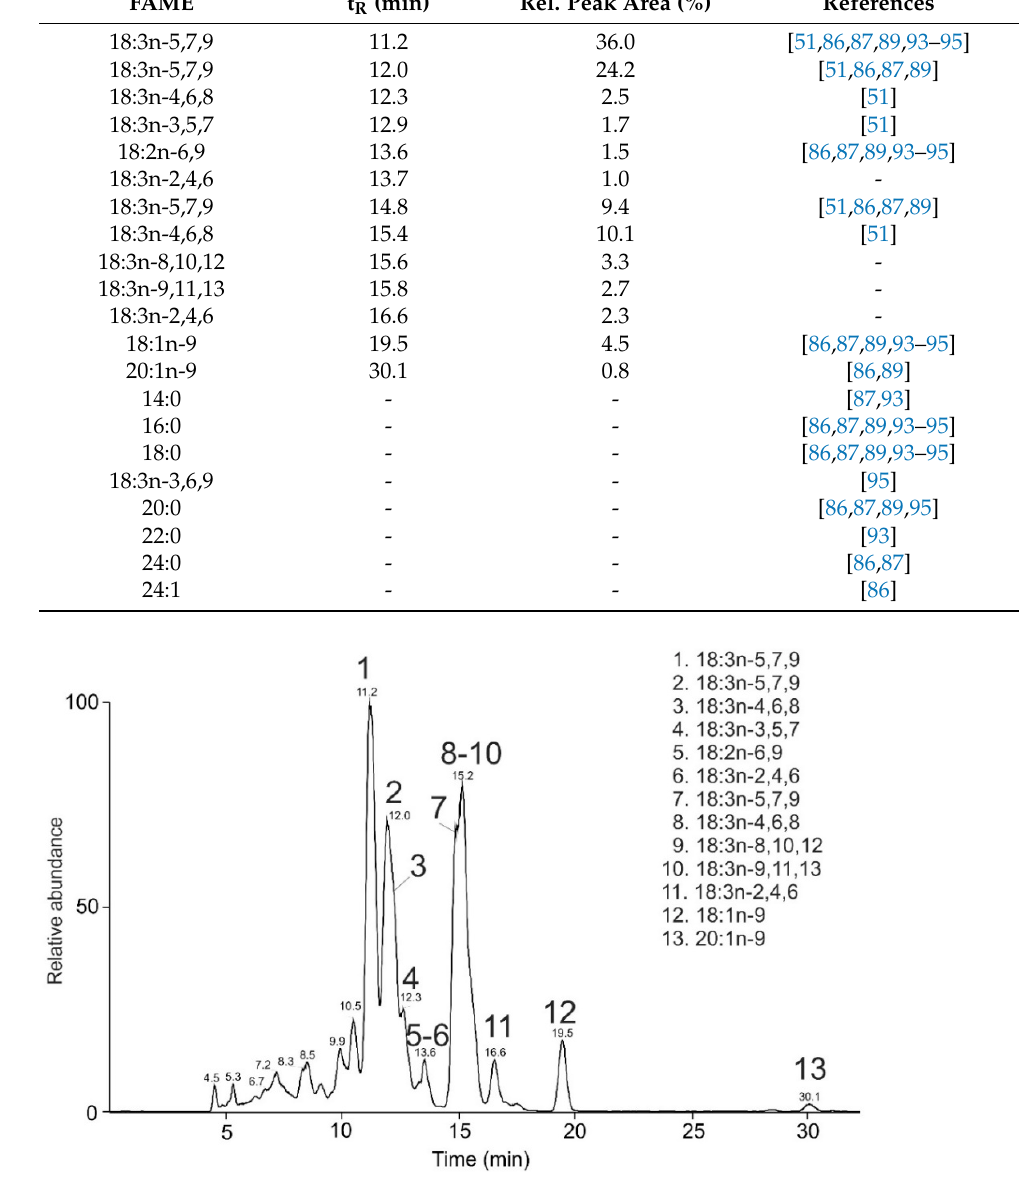
Figure 7. HPLC/APCI-MS base-peak chromatogram of FAMEs obtained from Punicum granatum seed oil and the list of identified species.